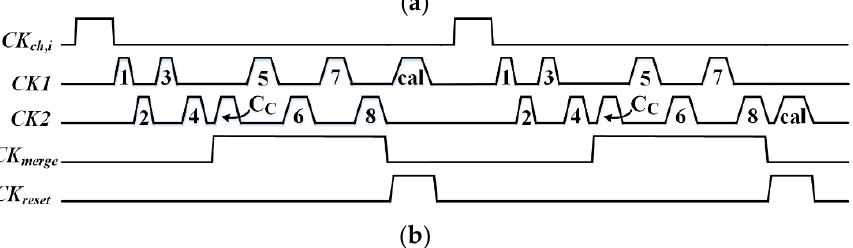
Figure 4. ( a ) SAR ADC overview, and ( b ) asynchronous timing diagram.